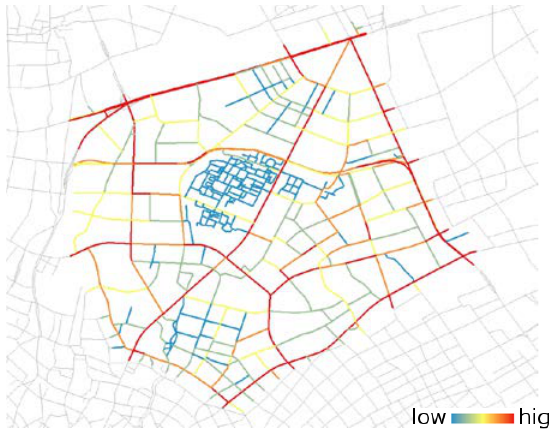
Figure 14. Simulated betweenness centrality values after integrate interior roads, with the same ODs as in previous simulation.